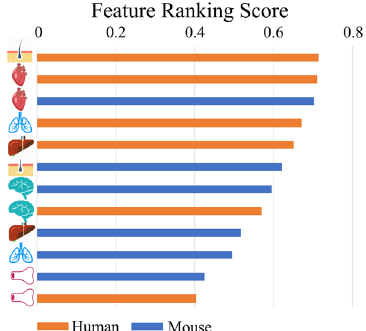
Figure 7. Ranking of the features in the homogeneous setting.